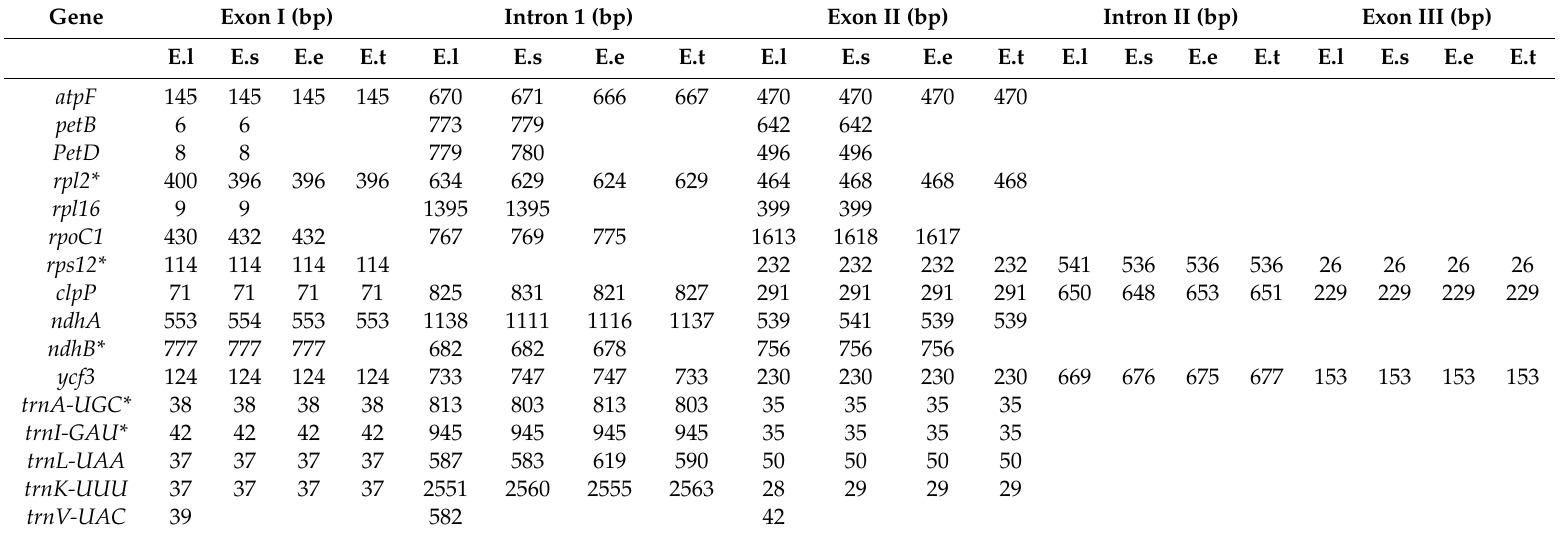
Table 2. The genes with introns in the Euphorbia species chloroplast genome and the length of exons and